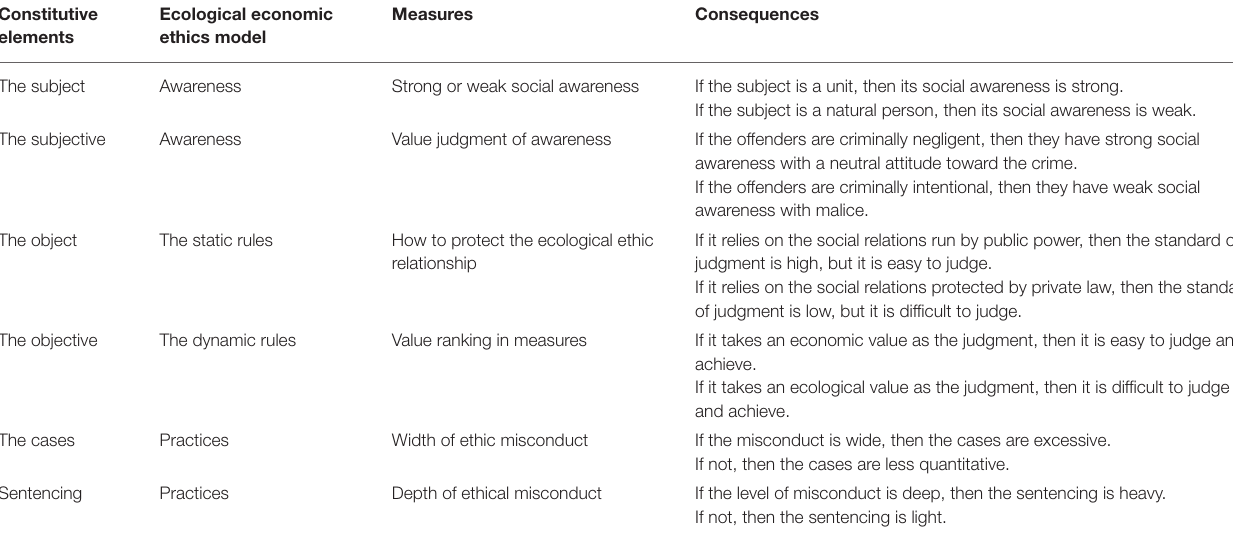
TABLE 8 | Ecological economic ethics model of wildlife crimes (18).